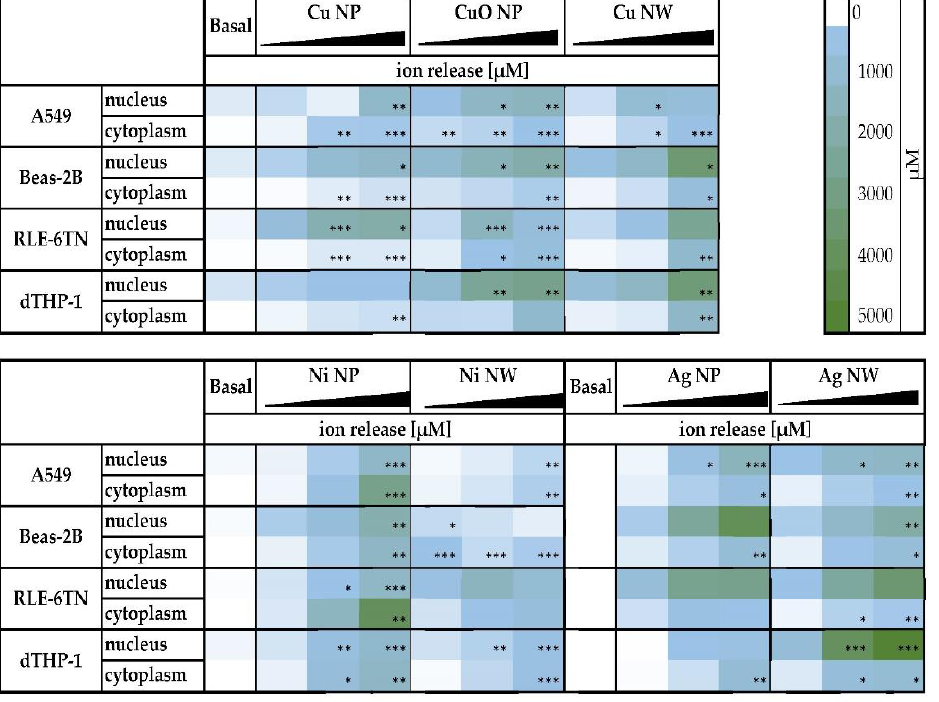
Figure 5. Intracellular distribution in cytoplasm and nucleus of A549, Beas-2B, RLE-6TN and dTHP-1 cells after incubation with three doses metal-based nanomaterials. Significantly different from basal concentration: * p ≤ 0.05, ** p ≤ 0.01, *** p ≤ 0.001 (ANOVA - Dunnet’s t- test).